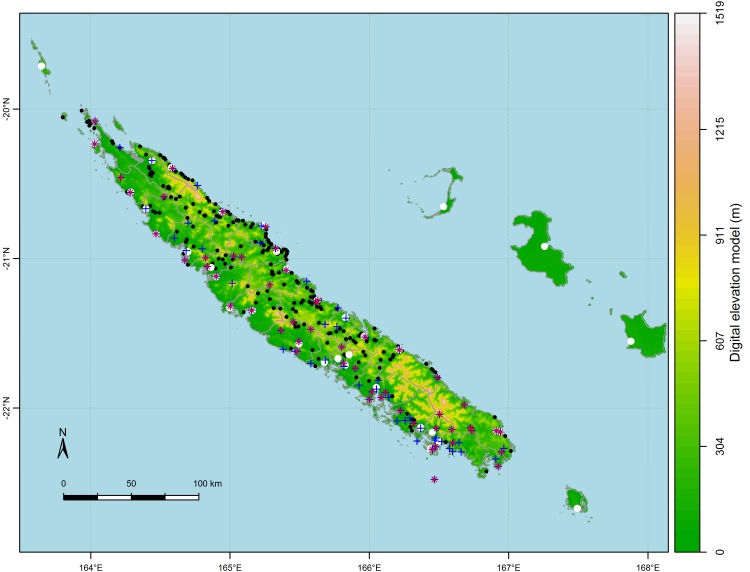
General map of New Caledonia.The map shows the location of towns (white dots), tribes (black dots), and weather stations registering temperature (red crosses) and rainfall (blue crosses) in New Caledonia. The background colour represents the digital elevation model (altitude).